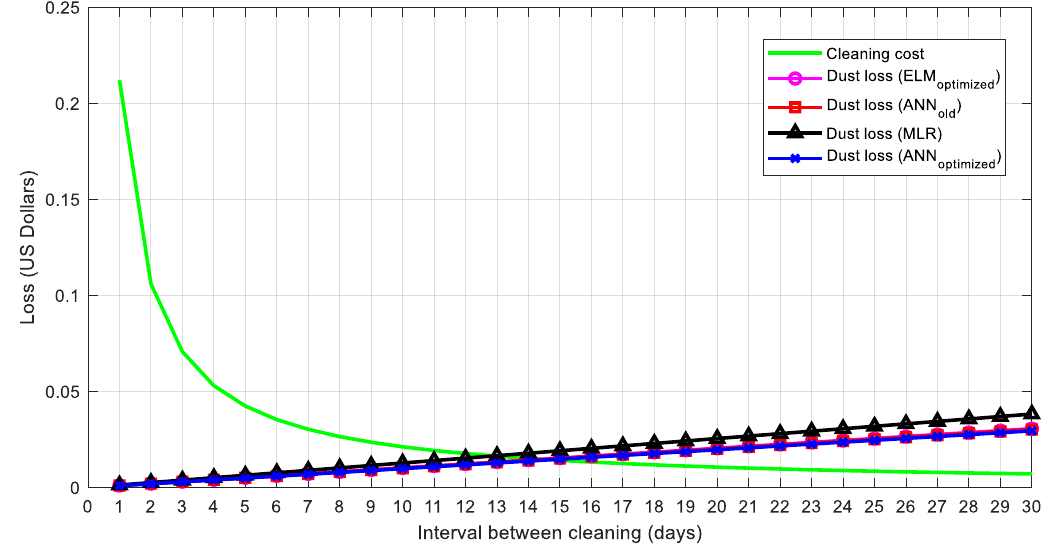
Figure 8. Average daily losses due to cleaning cost (inversely proportional curve) and losses due to dust accumulation (linear curves) obtained by the four prediction models.